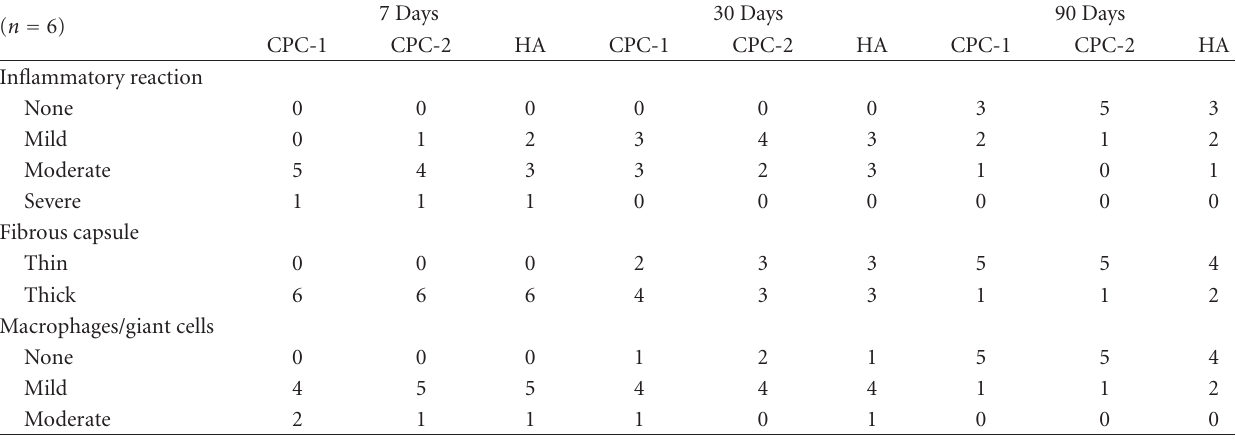
Table 5: Scores determined for each histological feature according to the experimental and control groups and periods of evaluation. ( n = 6)